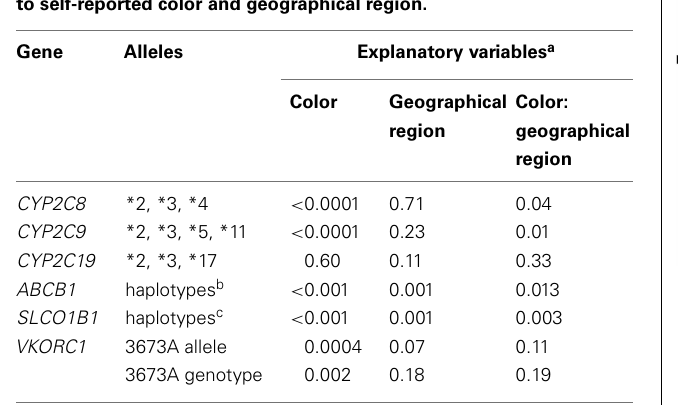
Table 2 | Multinominal log-linear analyses of the distribution of pharmacogenetic polymorphisms alleles among Brazilians according to self-reported color and geographical region.